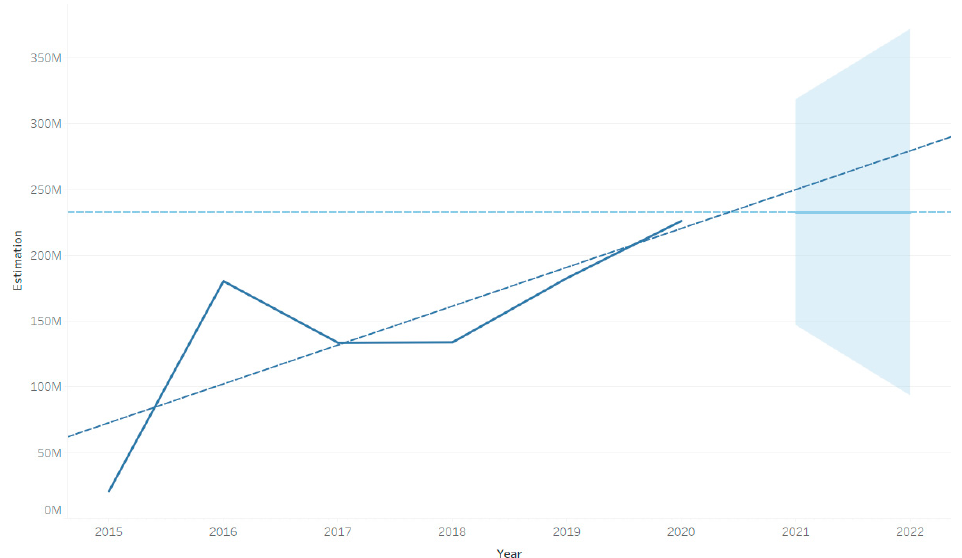
Figure 1. Estimated energy consumption from Bitcoin mining (annualized TWh). Source: Own elaboration using Tableau Desktop Professional Edition and data extracted in May 2021 from the University of Cambridge.